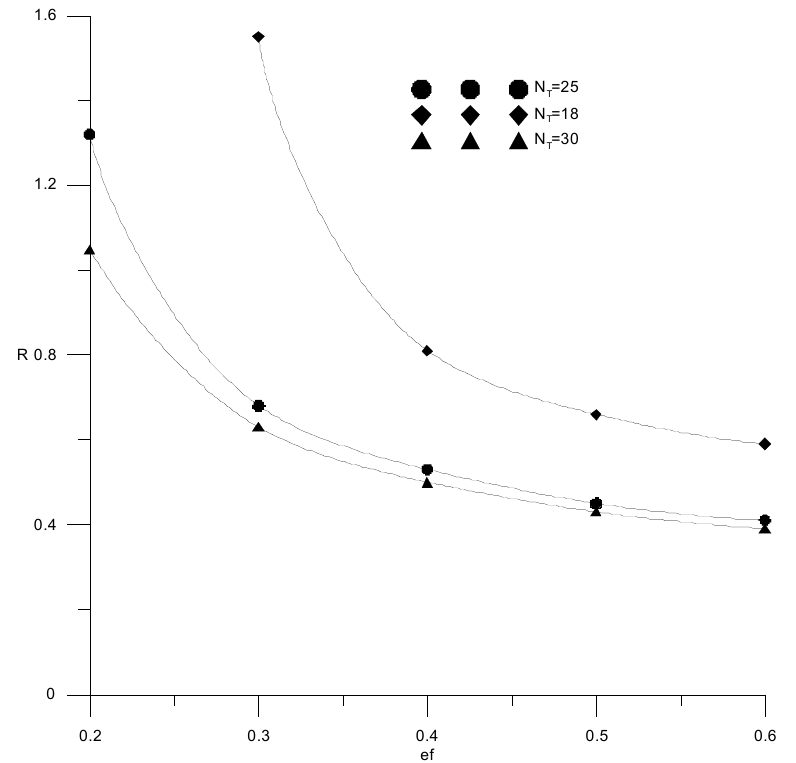
Figure 12. Change in reflux ratio from the amount of extractant supplied with a different number of trays (NT).